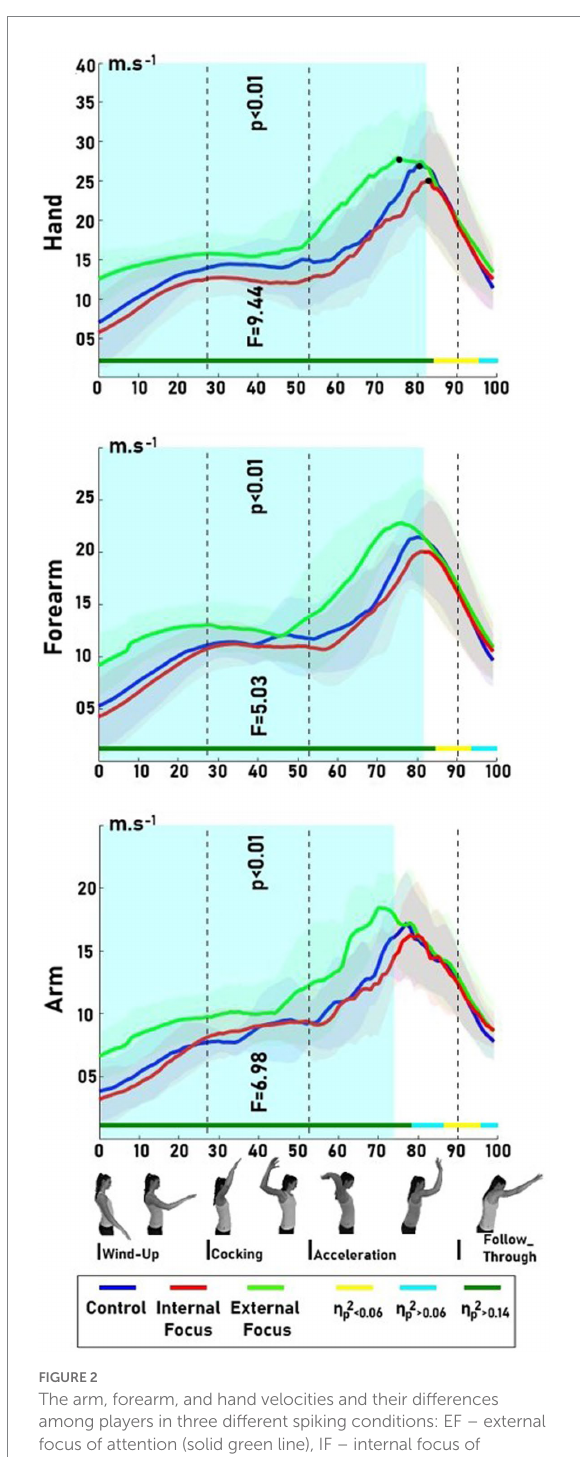
FIGURE 2 The arm, forearm, and hand velocities and their differences among players in three different spiking conditions: EF – external focus of attention (solid green line), IF – internal focus of attention (solid red line), and CON – control (solid blue line). The effect sizes were illustrated in dark green ( η p2 > 0.14), cyan ( η p2 > 0.06), and yellow ( η p2 < 0.06) at the bottom of each graph. The black dots in hand velocities depict the approximate impact moment at each spiking condition. Identification of spike phases (i.e., cocking) is approximate as every player began each phase at a different time